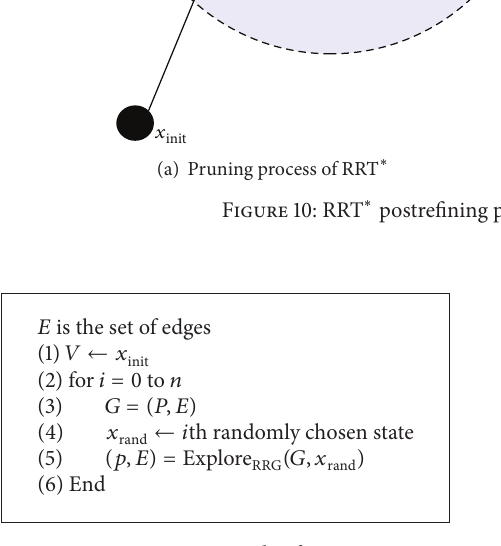
Algorithm 1: Body of RRG.